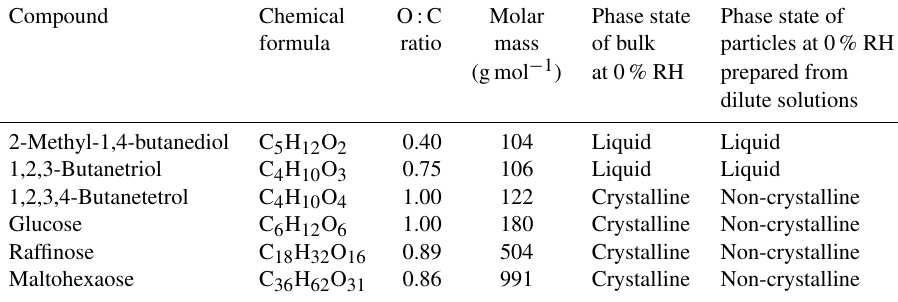
Table 1. Properties of polyol and saccharide compounds studied experimentally. Compound Chemical O:C Molar Phase state Phase state of formula ratio mass of bulk particles at 0% RH (gmol − 1 ) at 0% RH prepared from dilute solutions 2-Methyl-1,4-butanediol C 5 H 12 O 2 0.40 104 Liquid Liquid 1,2,3-Butanetriol C 4 H 10 O 3 0.75 106 Liquid Liquid 1,2,3,4-Butanetetrol C 4 H 10 O 4 1.00 122 Crystalline Non-crystalline Glucose C 6 H 12 O 6 1.00 180 Crystalline Non-crystalline Raffinose C 18 H 32 O 16 0.89 504 Crystalline Non-crystalline Maltohexaose C 36 H 62 O 31 0.86 991 Crystalline